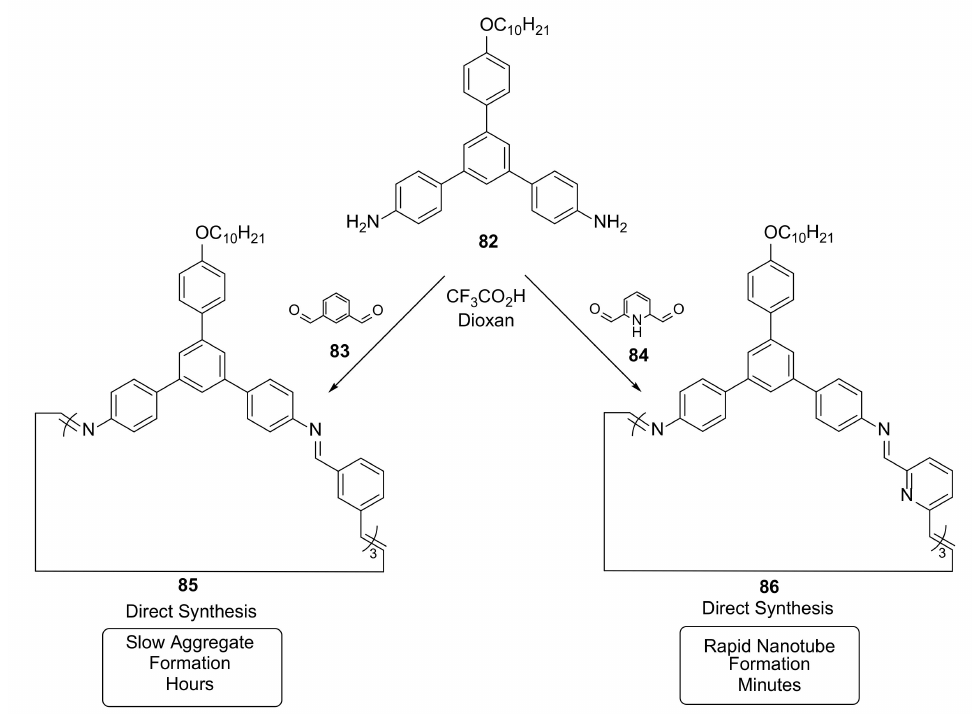
Figure 16. Formation and aggregation of macrocycles 85 and 86 from diamine 82 and isostructural dialdehydes 83 and 84